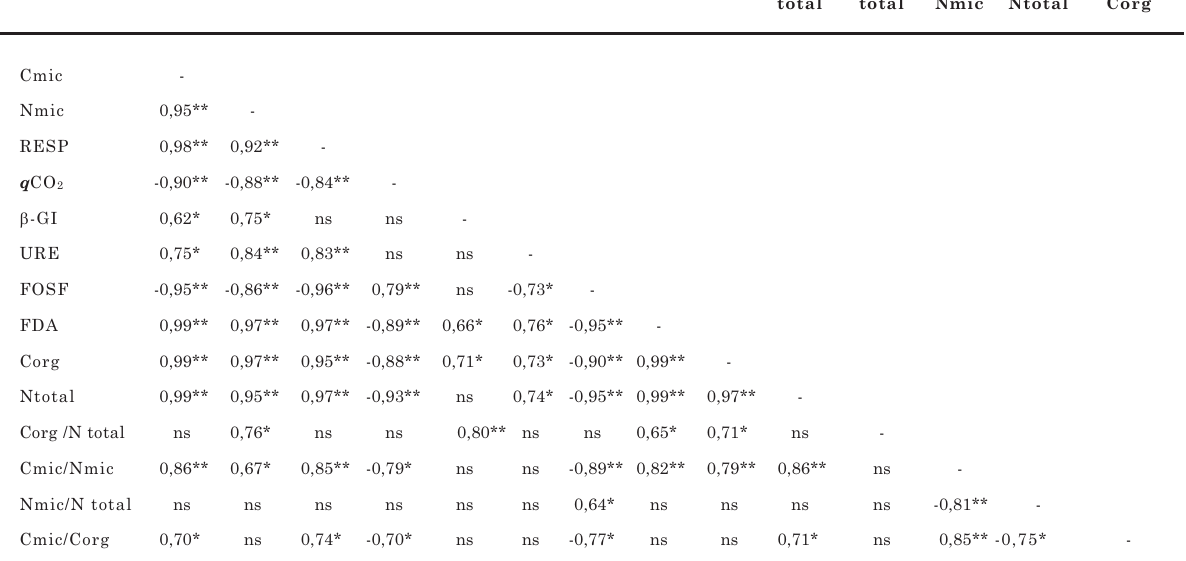
obtido pelo método Kjeldahl. * e ** : correlações significativas a 5 e 1 %, respectivamente; ns: não-significativo pelo teste